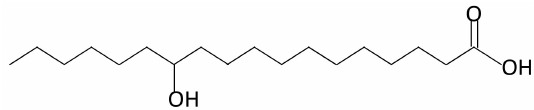
Figure 1. Chemical structure of 12-hydroxystearic acid